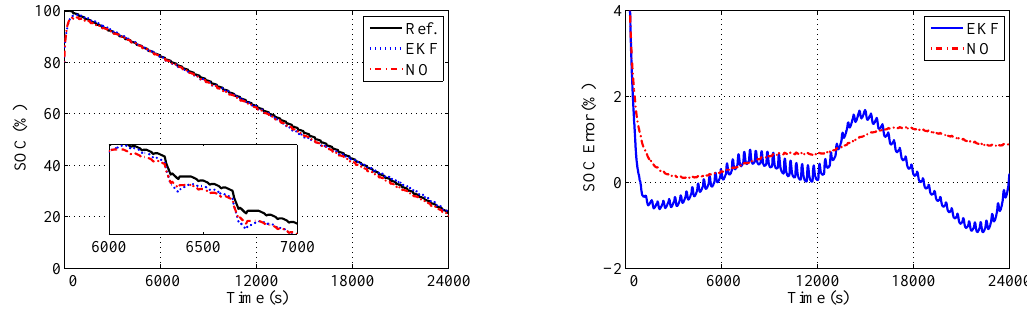
Figure 9. Robustness validation 2, capacity uncertainties caused by